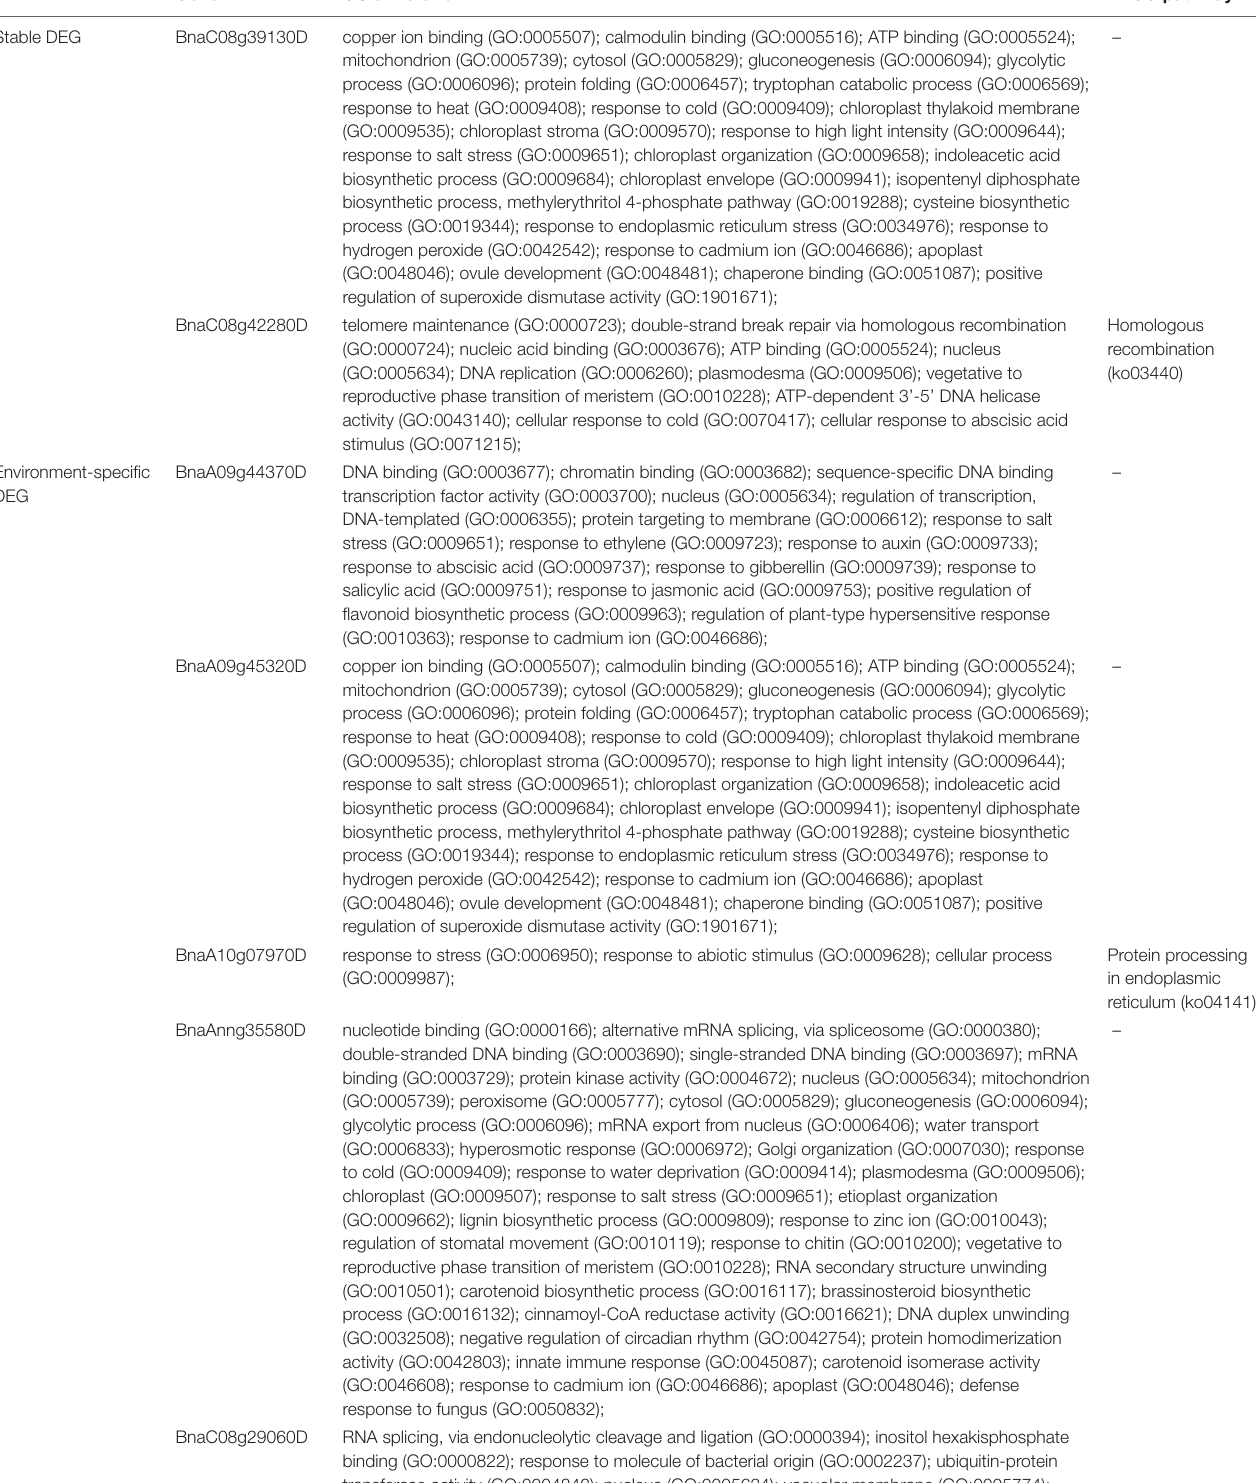
TABLE 2 | Annotations for important stable and environment-specific